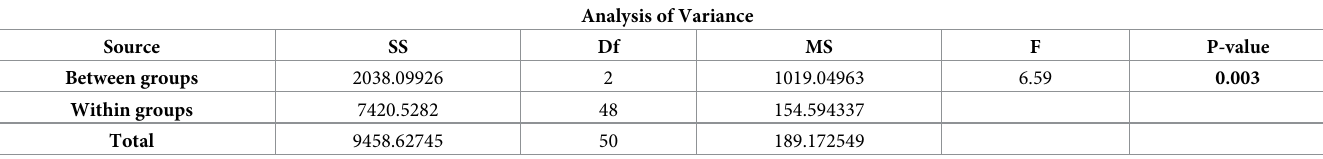
Table 4. Comparison of mean ALT with age categories among cases (one way ANOVA).